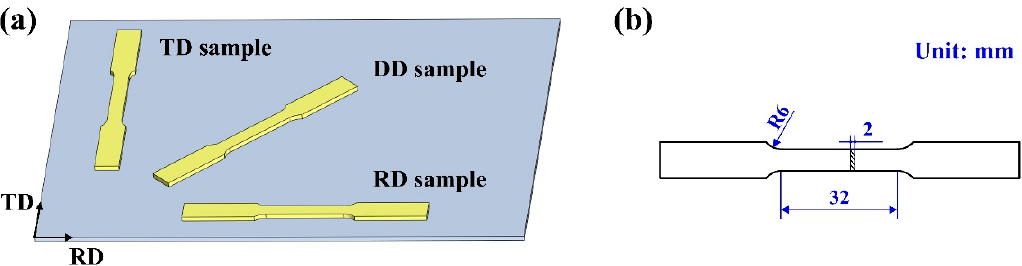
Figure 1. ( a ) The loading orientation and ( b ) geometrical dimensions of the tensile sample.